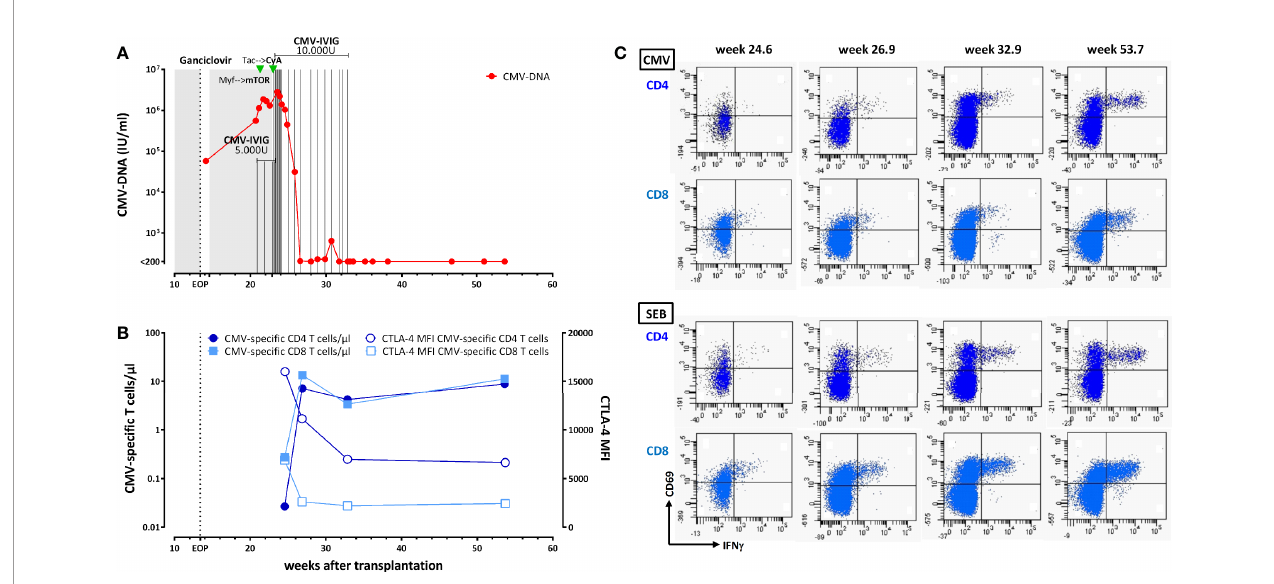
FIGURE 1 | Control of cytomegalovirus (CMV) infection in a renal transplant recipient with a UL54 DNA polymerase gene mutation A834P. (A) Time course of CMV- DNAemia in relation to antiviral therapy with ganciclovir (i.v. and valganciclovir, shaded areas, for more information see text), modulation of immunosuppression from mycophenolate mofetil (myf) to an mTOR inhibitor and from tacrolimus (Tac) to cyclosporine A (CyA). In addition, the patient received CMV-speci fi c i.v. immunoglobulins (IVIG). (B) Time course of absolute numbers of CMV-speci fi c CD4 and CD8 T cells (black symbols) determined by fl ow-cytometry after speci fi c stimulation with a CMV lysate and CMV peptides. In addition the expression level of CTLA-4 was determined [denoted as MFI (median fl uorescence intensity)]. (C) Original data of CMV-speci fi c CD4 and CD8 T cells determined over time (upper panels). The bottom panels show the time course in CD4 and CD8 T cells polyclonally stimulated with Staphylococcus aureus Enterotoxin B (SEB). Speci fi cally activated T cells were characterized by expression of CD69 and interferon g (IFN g